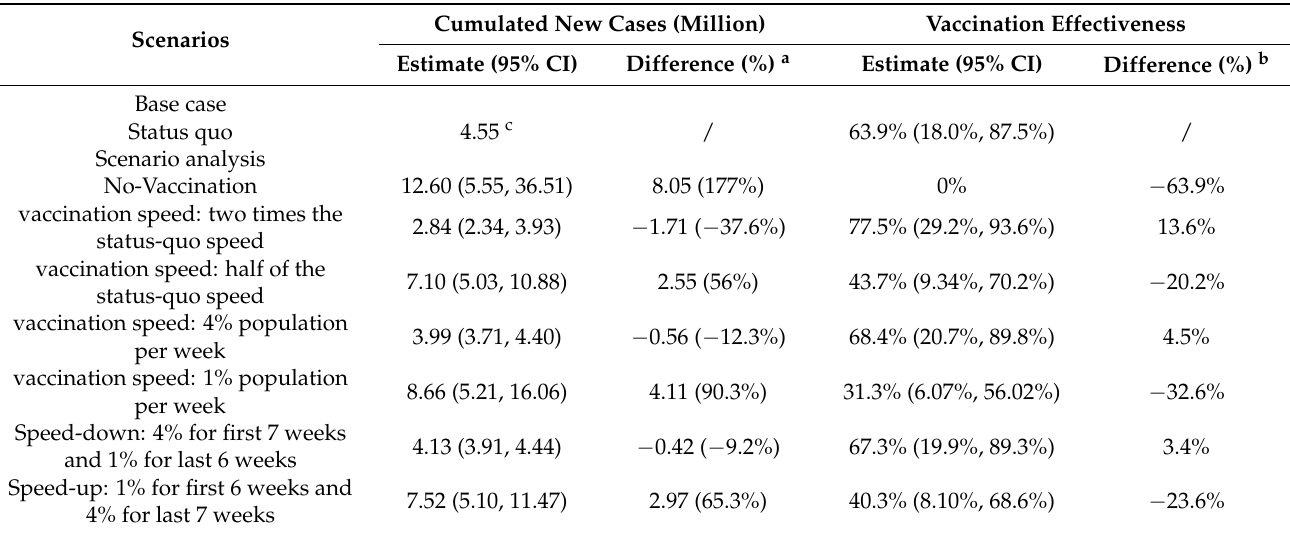
Table 3. Results of the base case and scenario